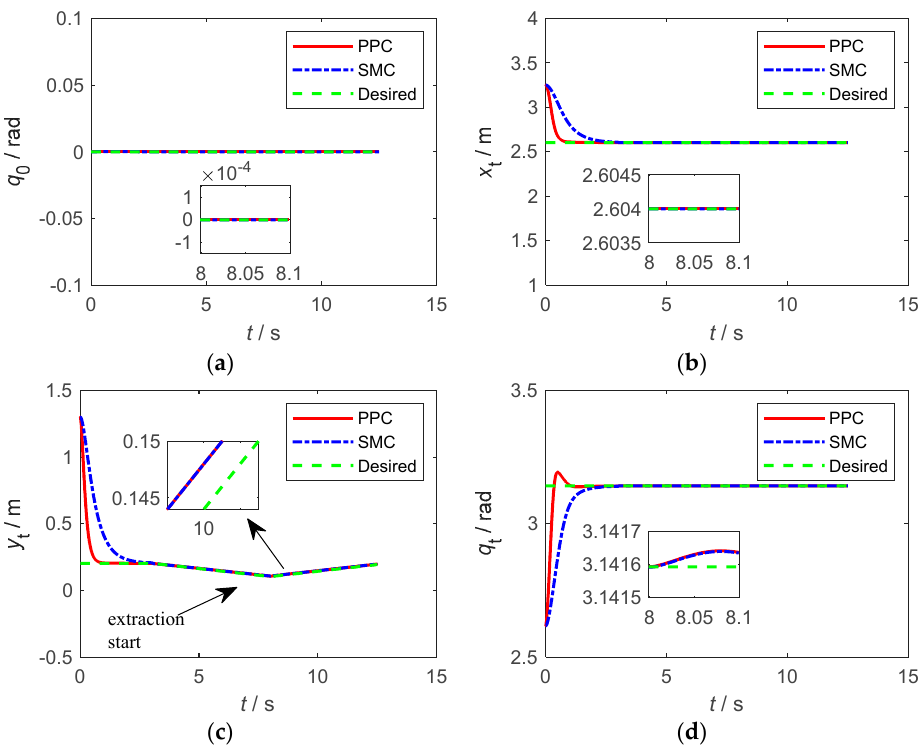
Figure 15. Space robot end trajectory tracking curve of on-orbit extraction operation. ( a ) The carrier attitude. ( b ) The X-direction position. ( c ) The Y-direction position. ( d ) The space robot end attitude. Figure 16a–c are the joint tracking curve of space robot. The extracting operation